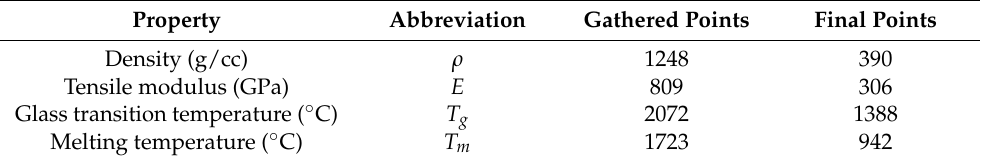
Table 1. Data counts for each property, describing the number initially gathered from PoLyInfo and the number remaining after processing. Property Abbreviation Gathered Points Final Points Density (g/cc) ρ 1248 390 Tensile modulus (GPa) E 809 306 Glass transition temperature ( ◦ C) T g 2072 1388 Melting temperature ( ◦ C) T m 1723